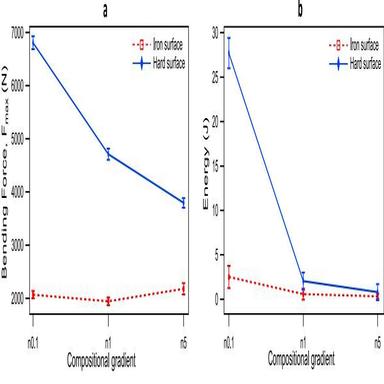
Graphs of a) maximum bending force, b) bending energy with respect to increasing gradients.